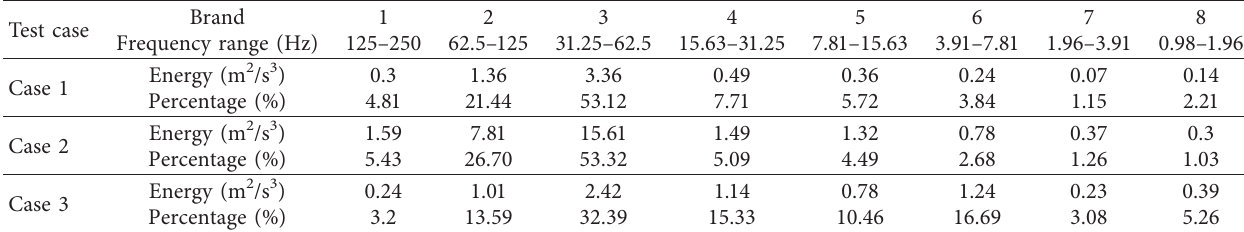
Table 3: Energy of the motor bogie frame at each decomposition level and its percentage of the total energy in respect of different cases. Brand Test case